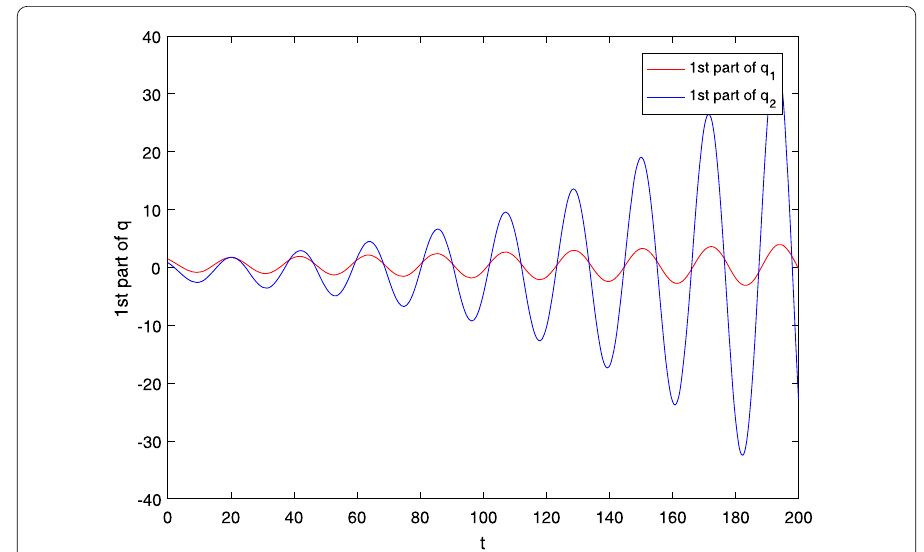
Figure 6 The first part of the state trajectories for system (1) with δ = 5.5